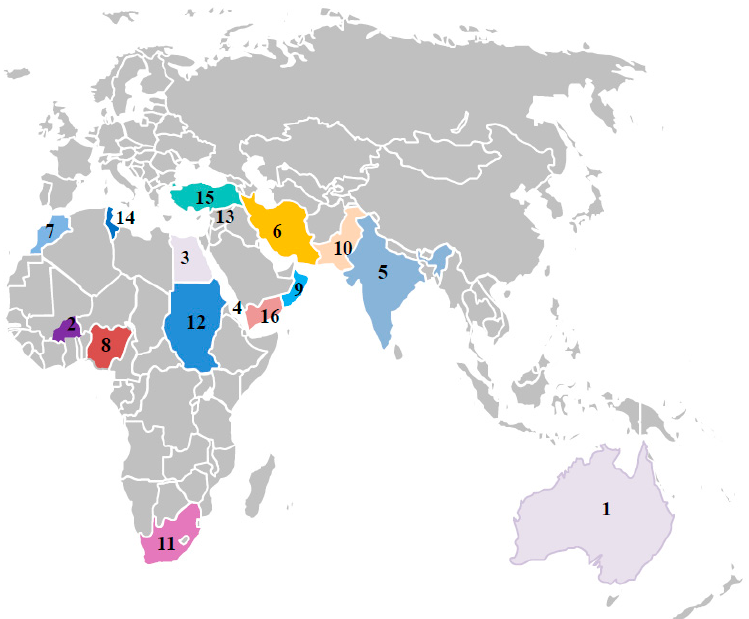
Figure 2. Geographical distribution of dicot infecting mastreviruses across the old world. 1. Australia